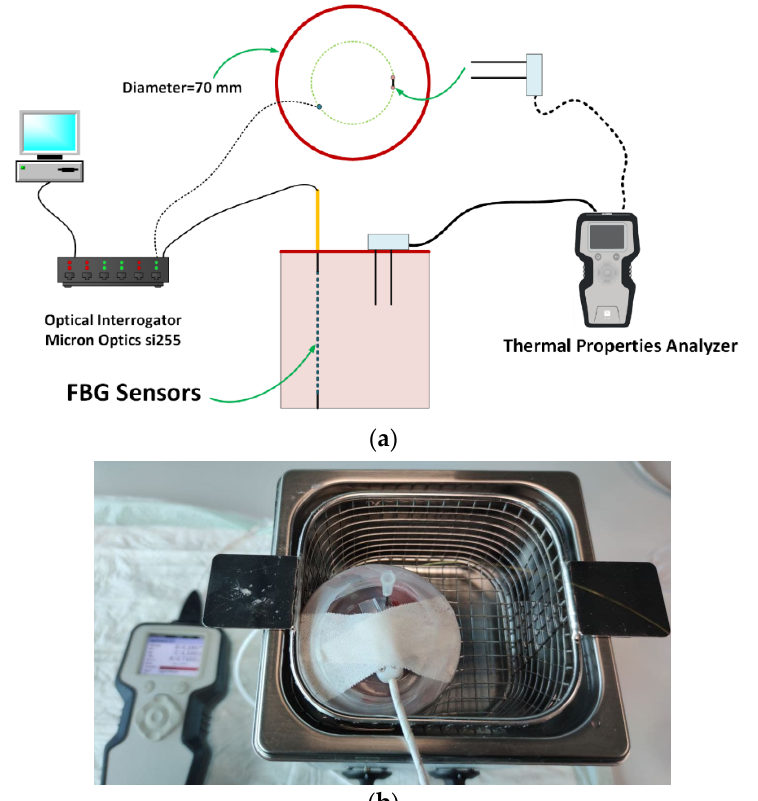
Figure 1. ( a ) Schematic view of the experimental setup; ( b ) picture of the container filled with liver, immersed in the temperature-controlled water bath, and including TEMPOS’s probe and needle housing FBG sensors.